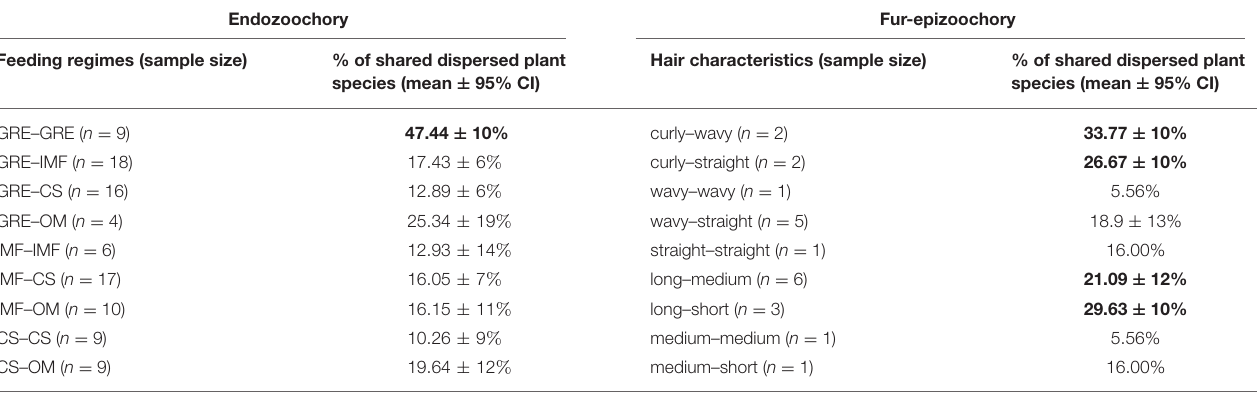
TABLE 6 | Proportion of shared dispersed plant species for different combinations of feeding regimes (CS: Concentrate Selector, IMF: Intermediate Mixed Feeder, GRE: Grass and Roughage Eater and OM: Omnivore) for endozoochory (left columns) and hair characteristics (hair curliness: curly, wavy and straight; hair length: short, medium and long as described in Albert et al., 2015b) for fur-epizoochory (right